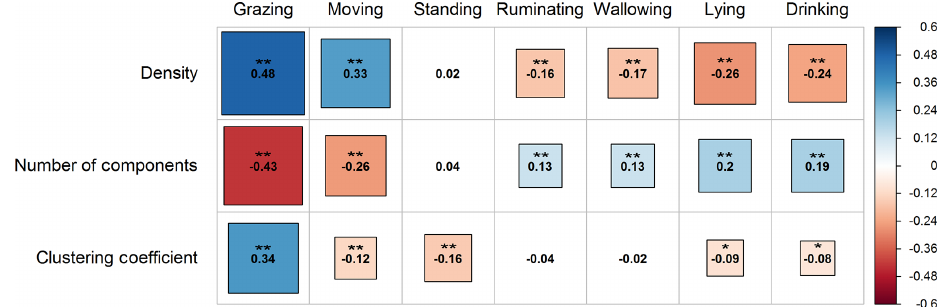
Figure 2. Correlogram presenting the pattern, the strength, and the significance level of Spearman’s rank correlations (two-tailed) between the global indices (density, number of components, and clustering coefficient) and water buffaloes’ activities on pasture (grazing, moving, standing, ruminating, wallowing, lying, and drinking). Red and blue colors represent negative and positive correlation, respectively. Darker colored and bigger square boxes in the panels correspond to higher strength of correlation. Asterisks indicate the statistically significant level of association at P < 0 . 05 ( ∗ ) and P < 0 . 01 ( ∗∗ ).